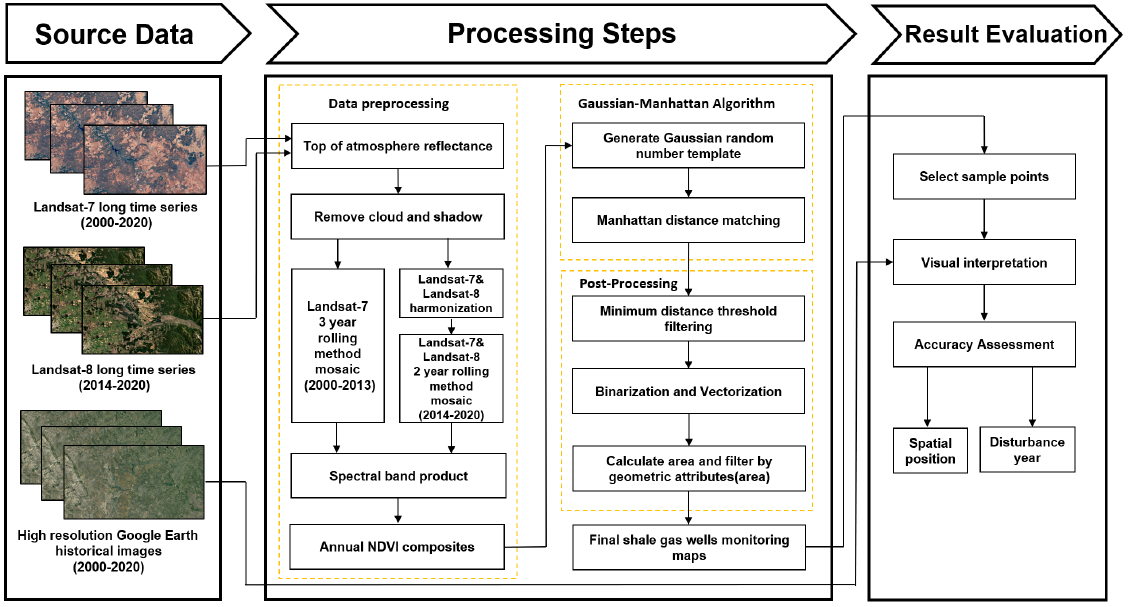
Figure 2. Research framework of shale oil/gas well